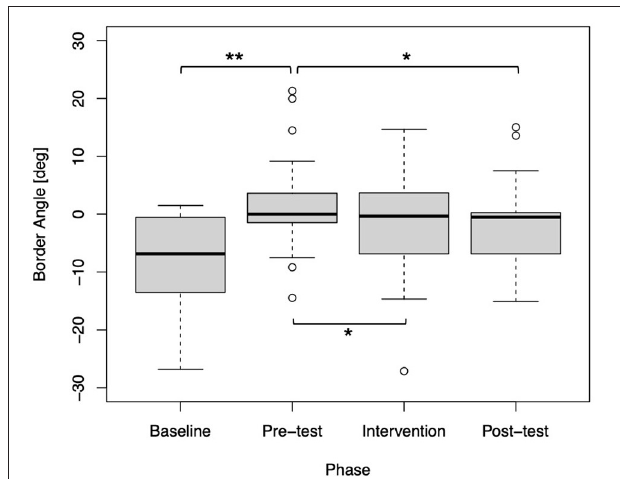
FIGURE 4 | Box plot of the border angles for each phase ( N = 43). Statistical significance was confirmed between the baseline and pre-test phases ( ∗∗ p < 0.01), the pre-test and intervention phases ( ∗ p < 0.05), and the pre-test and post-test phases ( p <